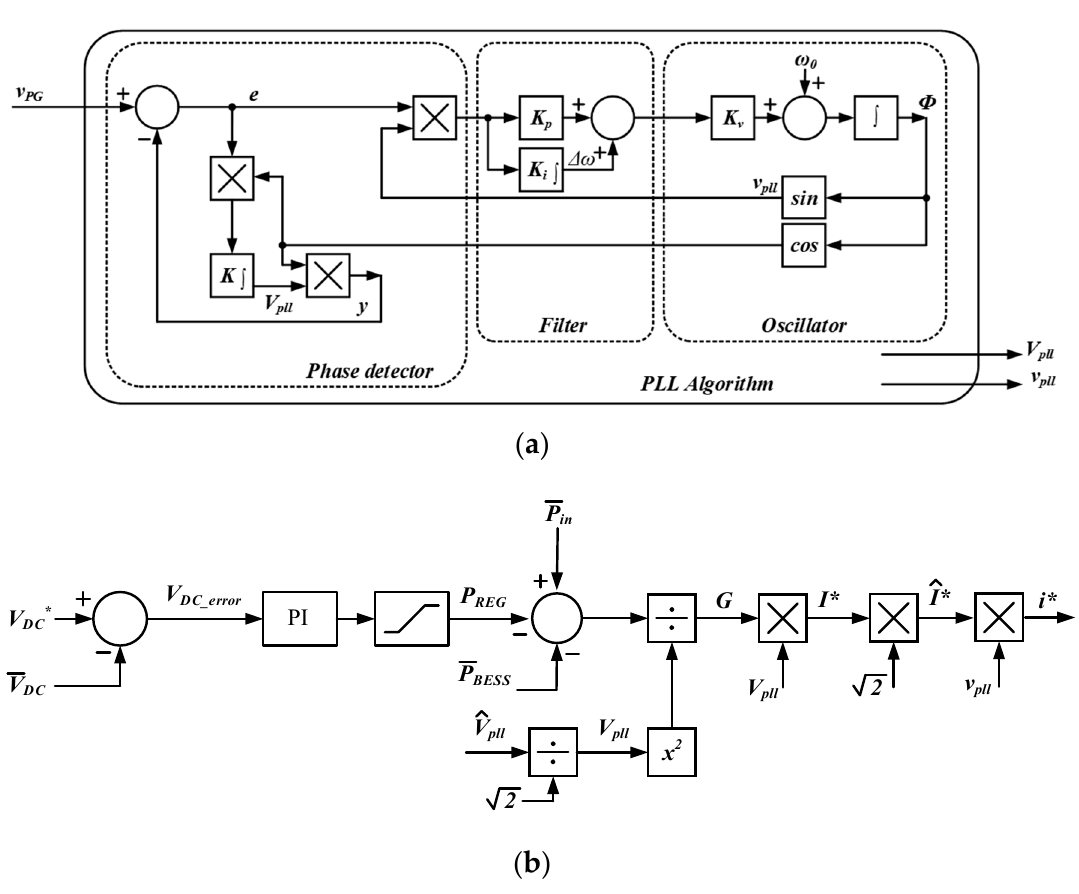
Figure 6. Block diagrams of the multifunctional isolated microinverter controls: ( a ) Phase-locked loop (PLL) control algorithm block diagram; ( b ) Current reference calculation block diagram.